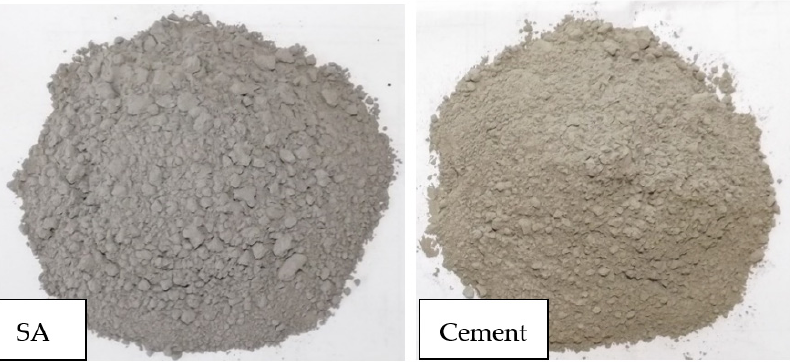
Figure 3. Sunflower ash resulted from ball grinding for 120 min. and used in mixes, compared to the cement.